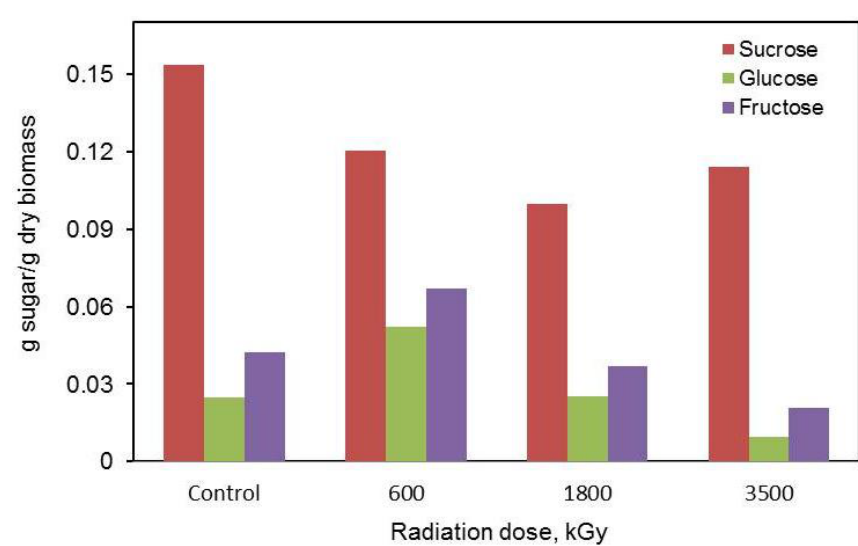
Figure 3. Sugars content in control and irradiated OP.